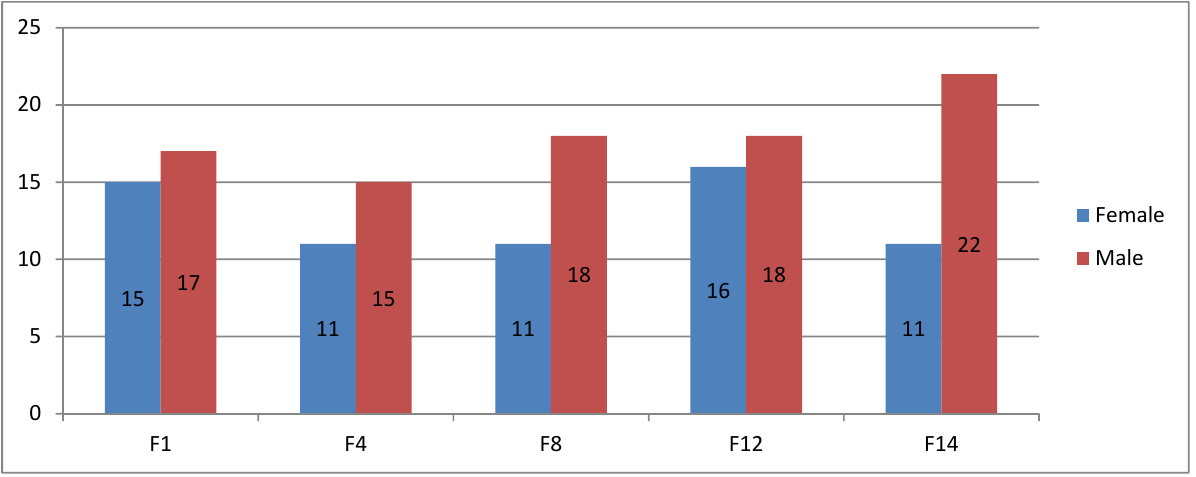
Fig. 1. The frequency of answers to personal questions